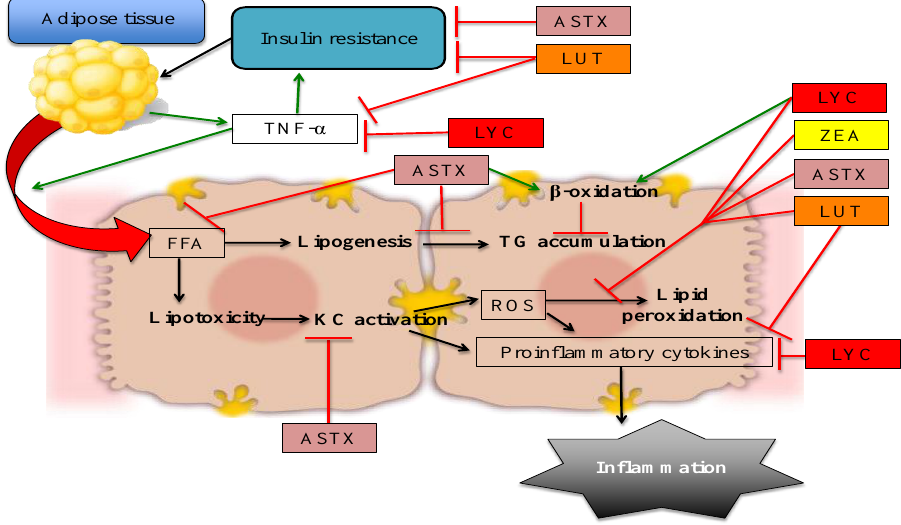
Figure 2. Non-provitamin A carotenoids have the potential to prevent or treat NAFLD by affecting different pathways: The quenching of ROS, thus decreasing oxidative stress and lipid peroxidation. However, other mechanisms include decreasing hepatic FFA influx, modulating expression of lipogenic and lipolytic genes, improving insulin signaling, and directly reducing inflammation. Red arrows denote blocked or decreased pathways whereas green arrows represent increased or